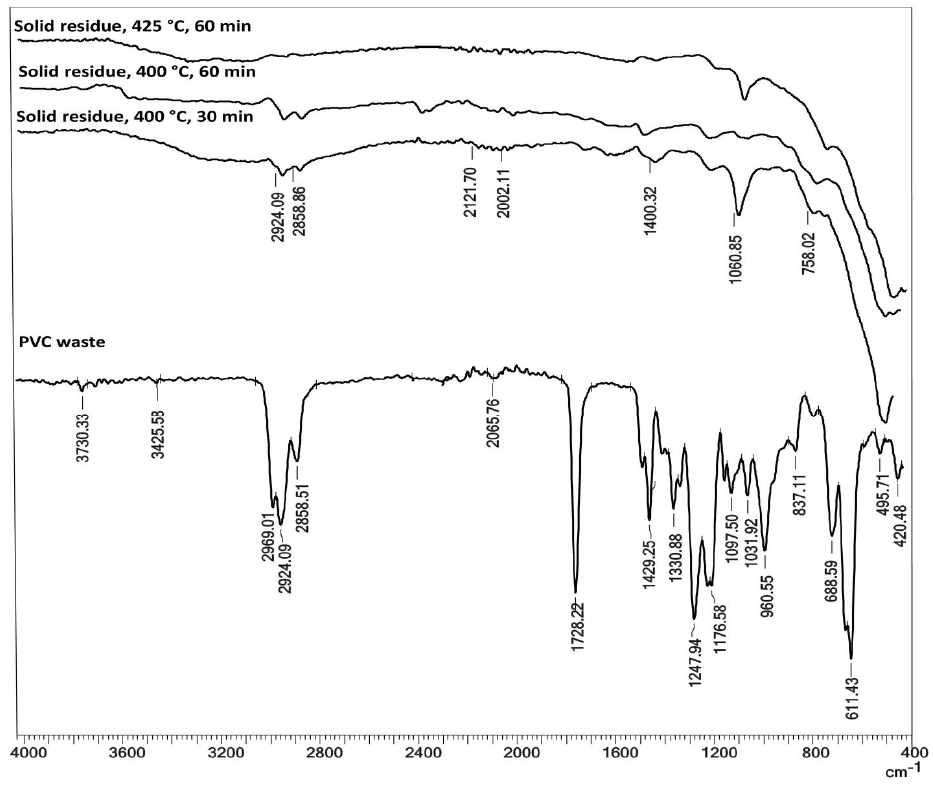
Figure 3. FTIR spectra of colorless PVC waste before and after hydrothermal degradation under different reaction conditions.